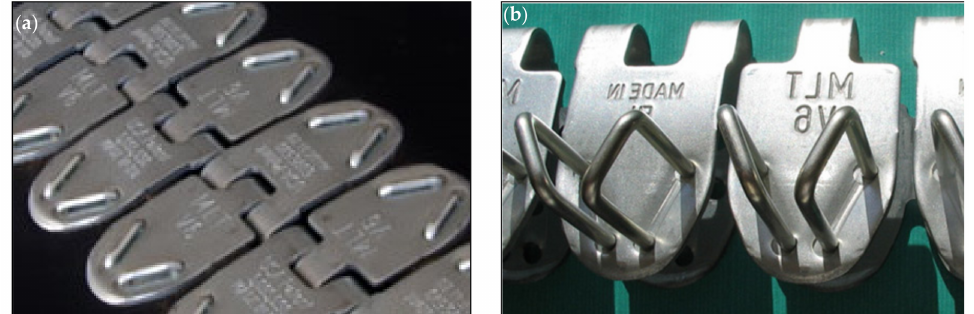
Figure 9. Staple fastening: ( a ) general view; ( b ) top view of the fastener [26]. The above two solutions are plate connections, i.e., those in which the hinge elements are in the form of bent plates.